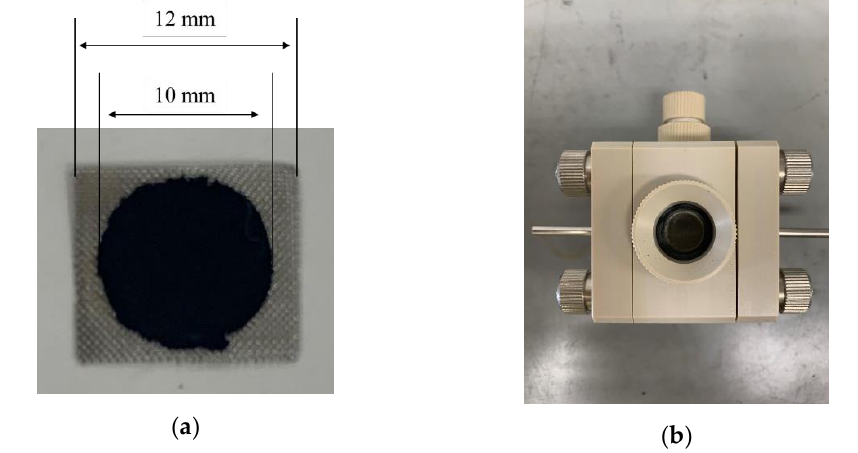
Figure 1. ( a ) Activated carbon electrode and ( b ) measurement